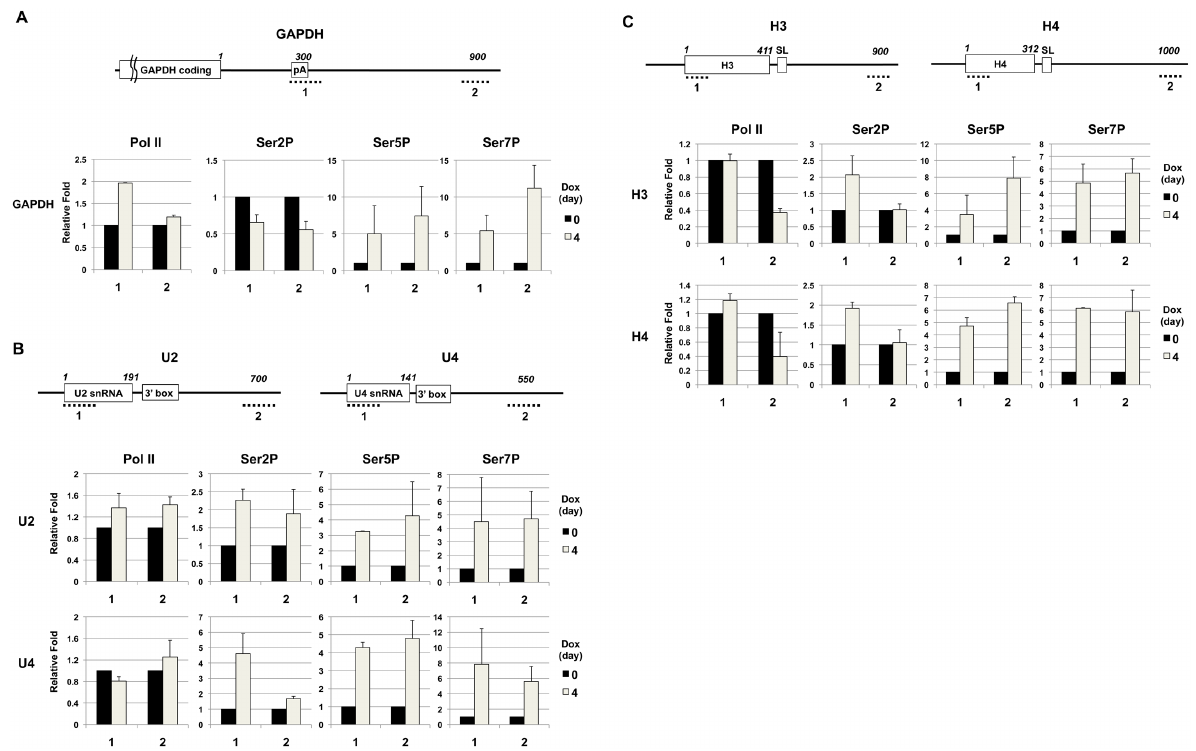
Figure 6. Ssu72 depletion causes hyperphosphorylation of the CTD on Pol II–transcribed genes. (A–C) ChIP analysis of the downstream region of the GAPDH gene (A), U2 and U4 snRNA genes (B), and histone H3 and H4 genes (C). (Upper) Diagrams of these genes with the coding regions, polyadenylation signals (pA), 3 9 box signals, and stem-loop sequences (SL) shown as open boxes. The numbers above these genes represent distance (in nucleotides) from the end of the coding region (for GAPDH ) or the transcription start site (for snRNA and histone genes). Dotted lines indicate the ChIP amplicons. (Lower) ChIP analysis of region 1 or 2 on the indicated genes, using antibodies against Pol II (N20), Ser2P (3E10), Ser5P (3E8), or Ser7P (4E12), in DT40 P3 ( 2 / 2 ) cells treated with Dox for 4 days (grey bars) or untreated (black bars). The y axe represents the fold change relative to the corresponding levels on day 0. The values for Ser2P, Ser5P or Ser7P signals were normalized by the total Pol II signal. Error bars represent standard deviations of two independent